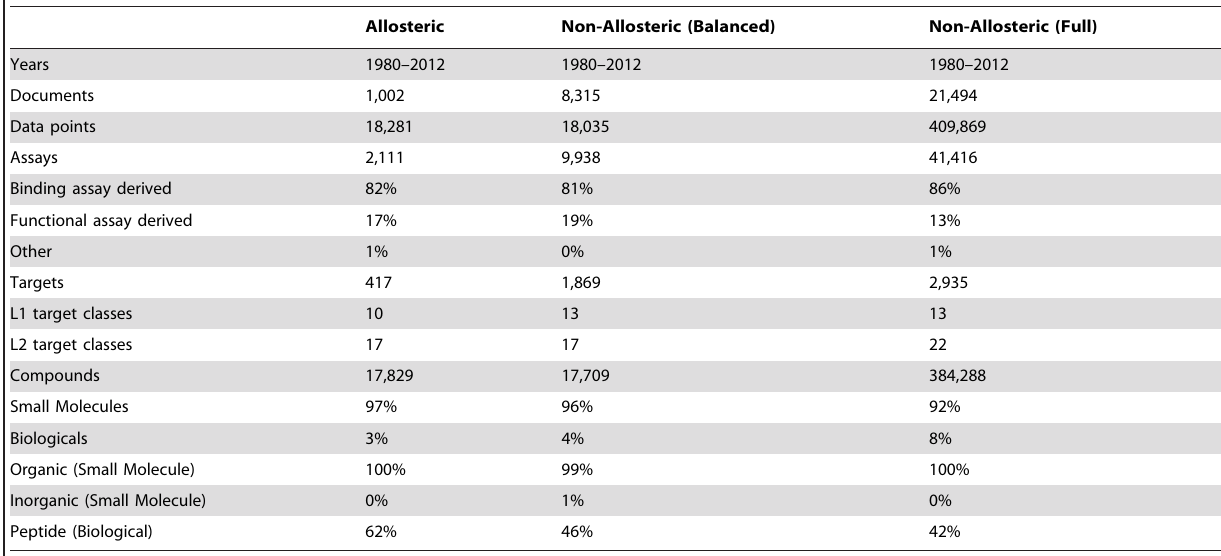
Table 1. Data set composition.